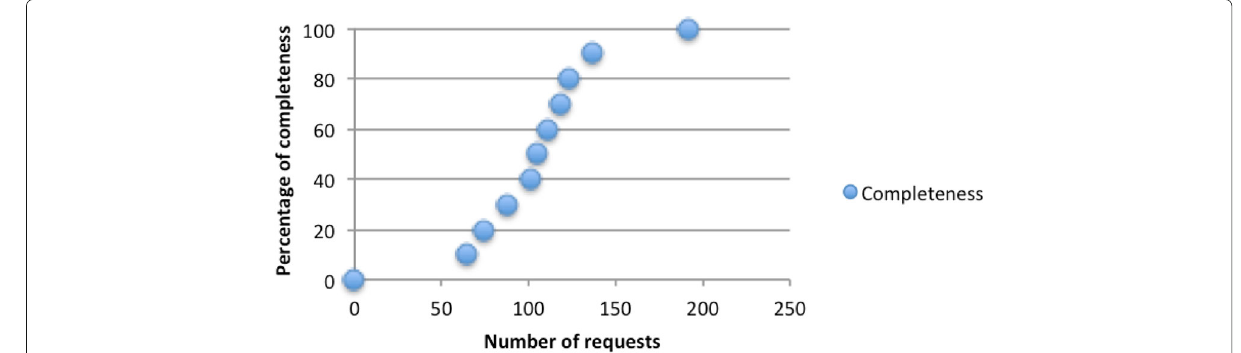
Fig. 16 Average of completeness